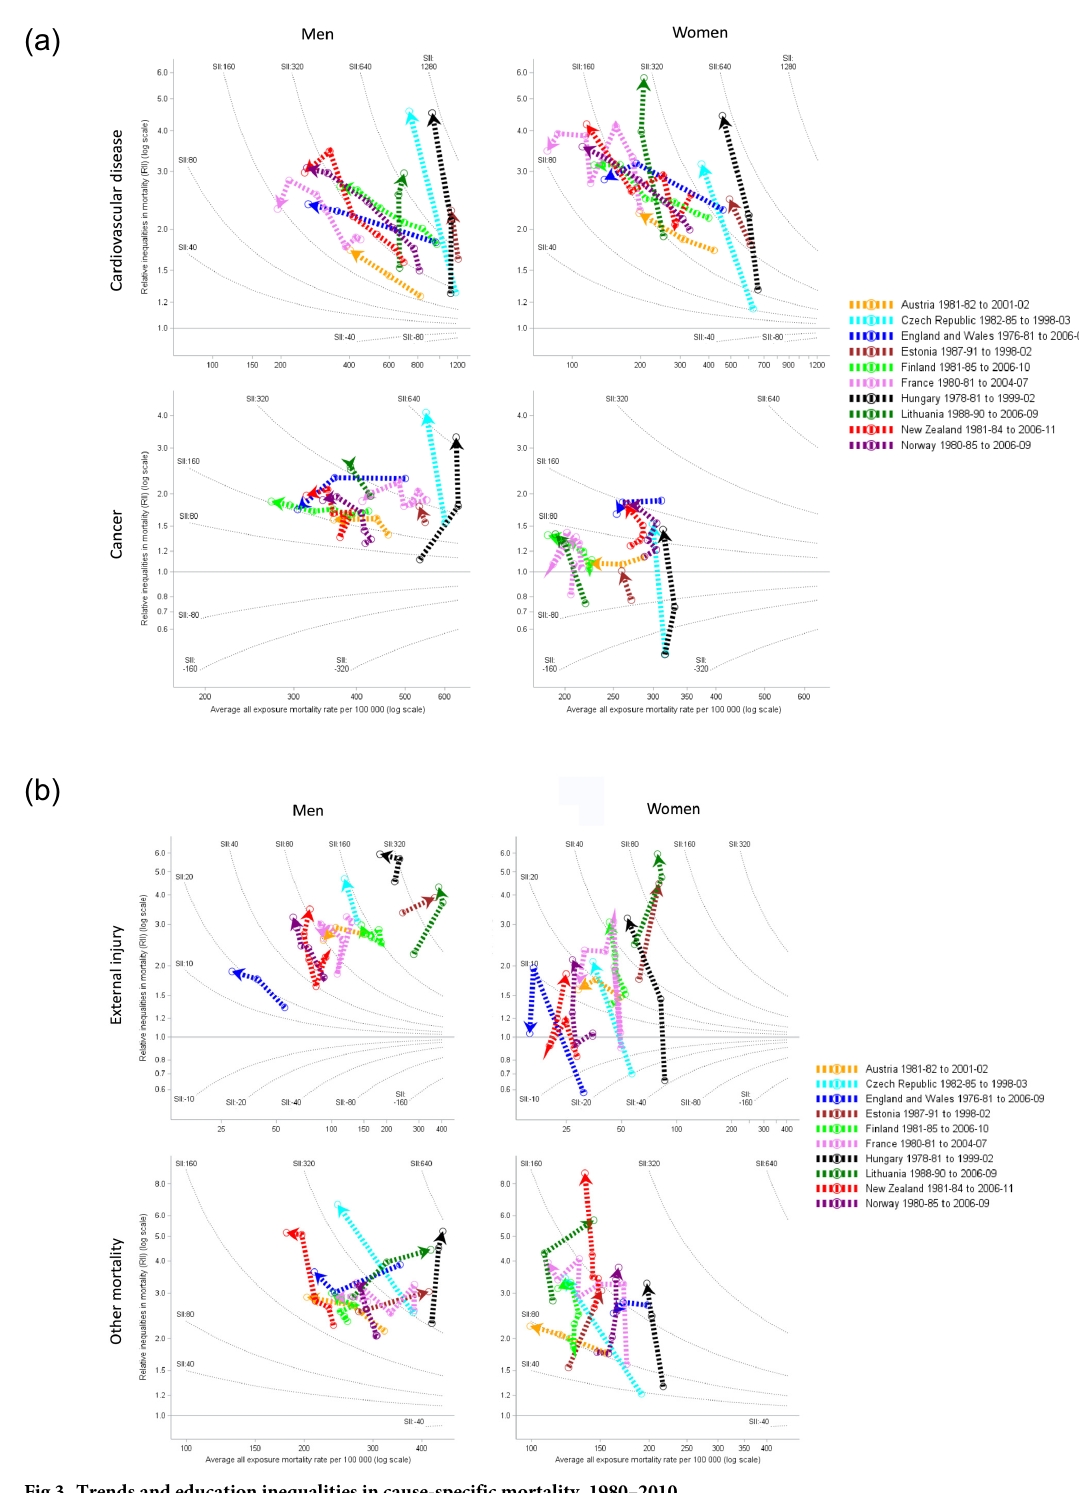
Fig 3. Trends and education inequalities in cause-specific mortality,